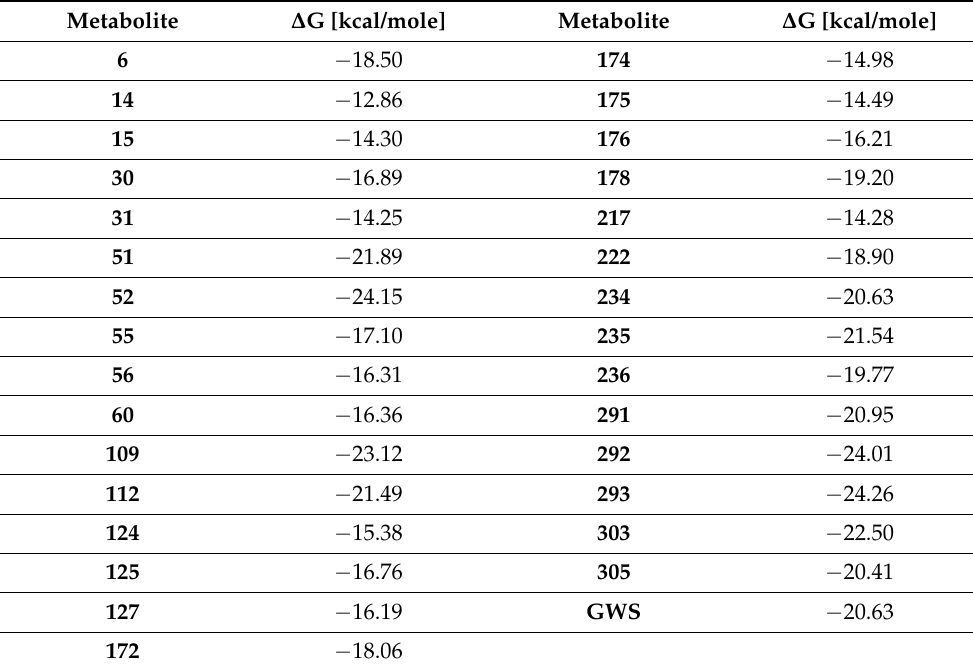
Table 1. The calculated ∆ G of the target metabolites and (GSW) inside M pro